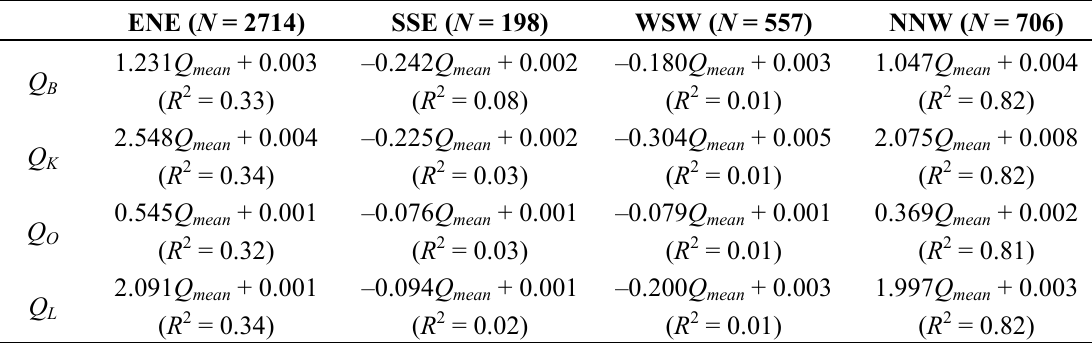
Table 1. Linear regression expressions for the relationships between Q , Q , Q , and Q for east-northeast, south-southeast, west-southwest, and n , and Q B K O L north-northwest winds. R 2 is the regression coefficient and N is the number of data points. See Figure 8 for related